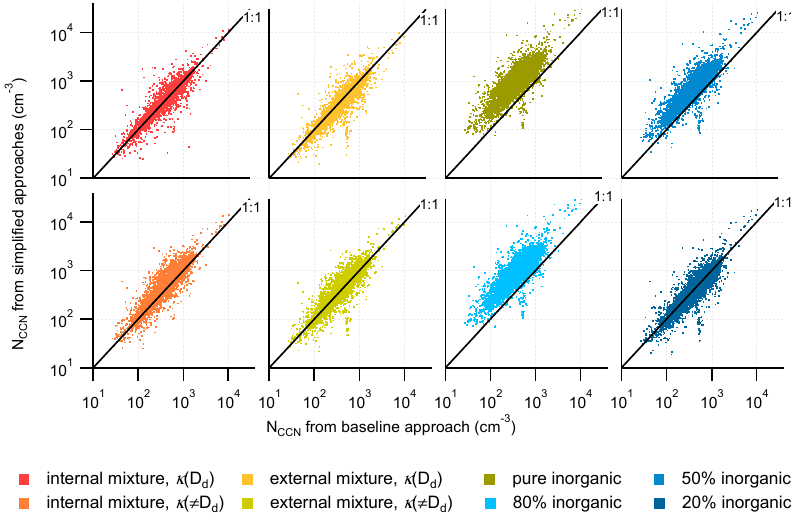
Figure 8. N CCN estimated from simplified approaches vs. that from the baseline approach at 0.25% S for all 2011 data.